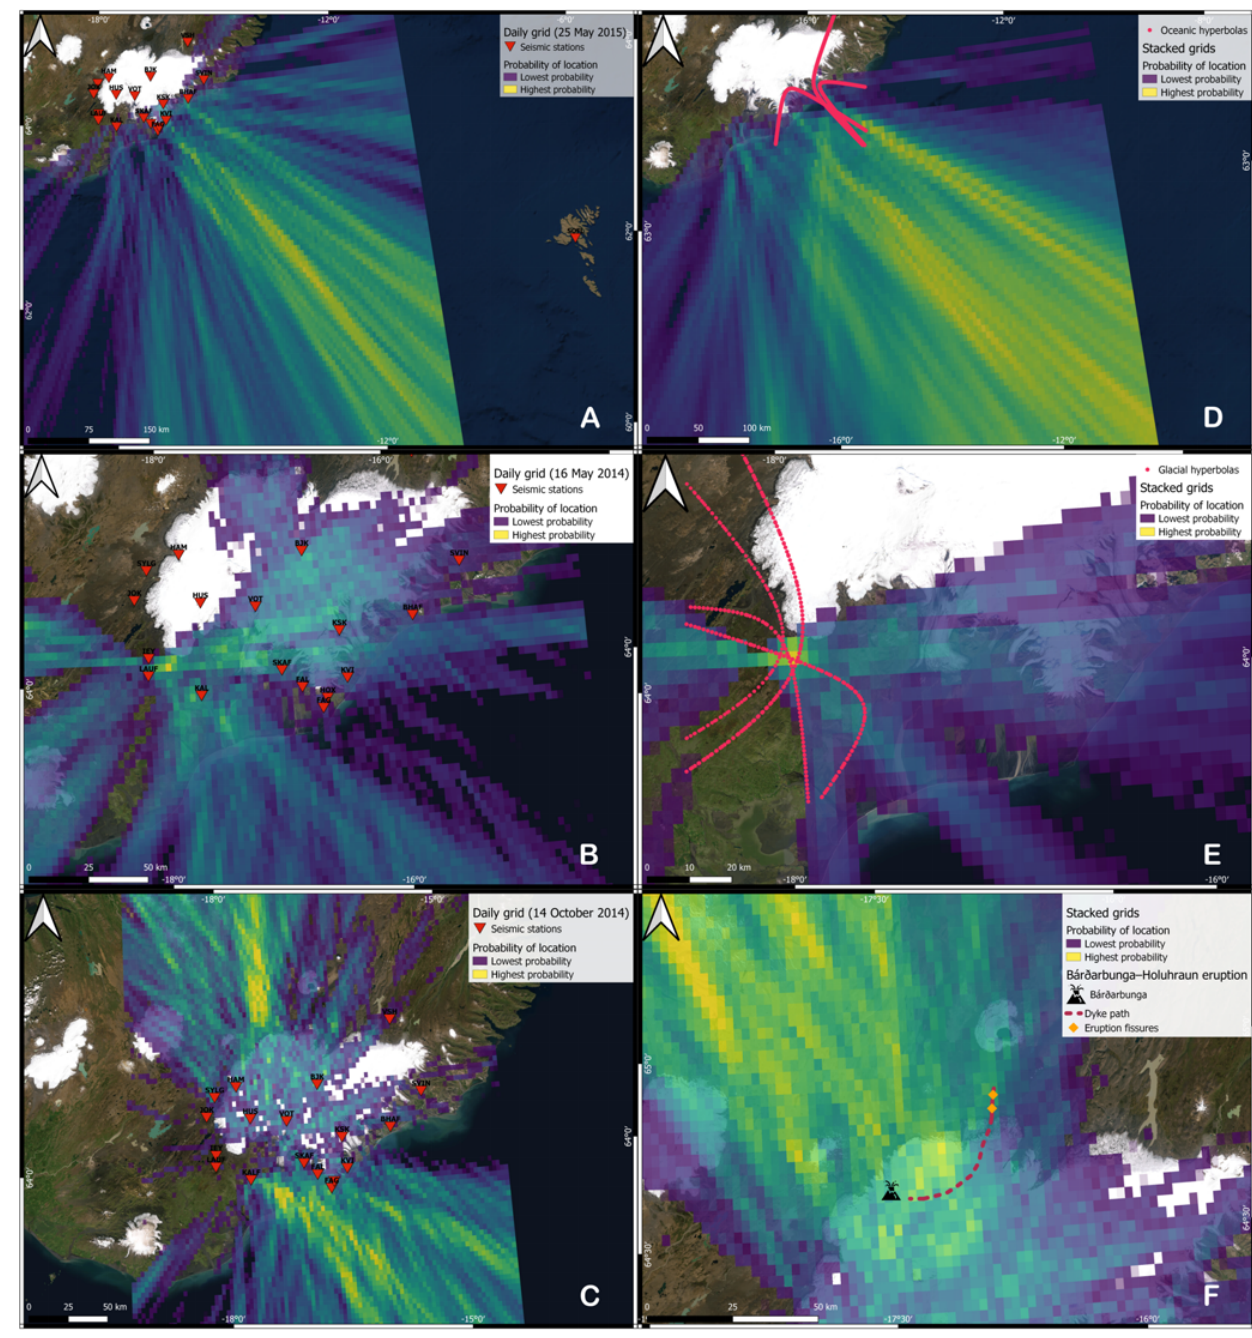
Figure 8: [A] to [C] Daily geographical grids assessed with the GS method showing the seismic stations and the probability of source location (summed stacked amplitudes) represented by the colour scale. [A] 25 th May 2015 for frequencies between 0.5 and 1.0 Hz and a propagation velocity of 1.89 km s −1 . [B]16 th May 2014 for frequencies between 4.0 and 8.0 Hz and for a propagation velocity of 2.79 km s −1 . [C] 14 th October 2014 for frequencies between 0.5 and 1.0 Hz and a propagation velocity of 1.89 km s −1 . [D] to [F] Maps of the stacked daily probabilities of location assessed with the GS method. Seismic stations are not represented for clarity. [D] Map of the Oceanic source for frequencies between 0.5 and 1.0 Hz and from 1 st May to 30 th July 2015. The propagation velocity is set at 1.89 km s −1 . Hyperbolas are the same as in Figure 6. [E] Map of the glacial source for frequencies between 4.0 and 8.0 Hz and from 10 th May to 15 th June 2014. The propagation velocity is set at 2.79 km s −1 . Hyperbolas are the same as in Figure 7. [F] Map for the Bárðarbunga–Holuhraun eruption for frequencies between 0.5 and 1 Hz and from 15 th August 2014 to 1 st February 2015. The propagation velocity is set at 1.89 km s −1 . The path of the dyke and the eruption fissures are shown as well and come from Woods et al.